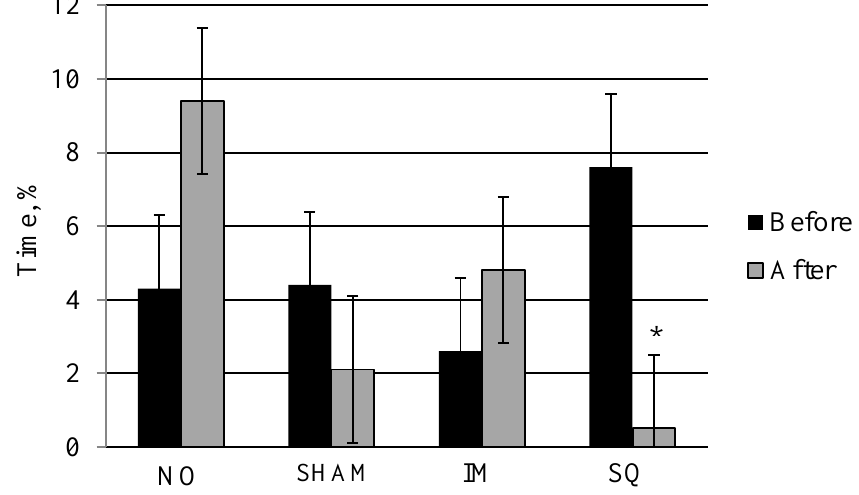
Figure 2. Least squares means for percent of time finishing pigs spent eating before and after receiving treatment ( p < 0.05): none (NO), Sham (SHAM), intramuscular (IM) injection, or subcutaneous (SQ) injection. N = 40 pig observations. * Within treatment, indicates a significant difference in means ( p < 0.05).